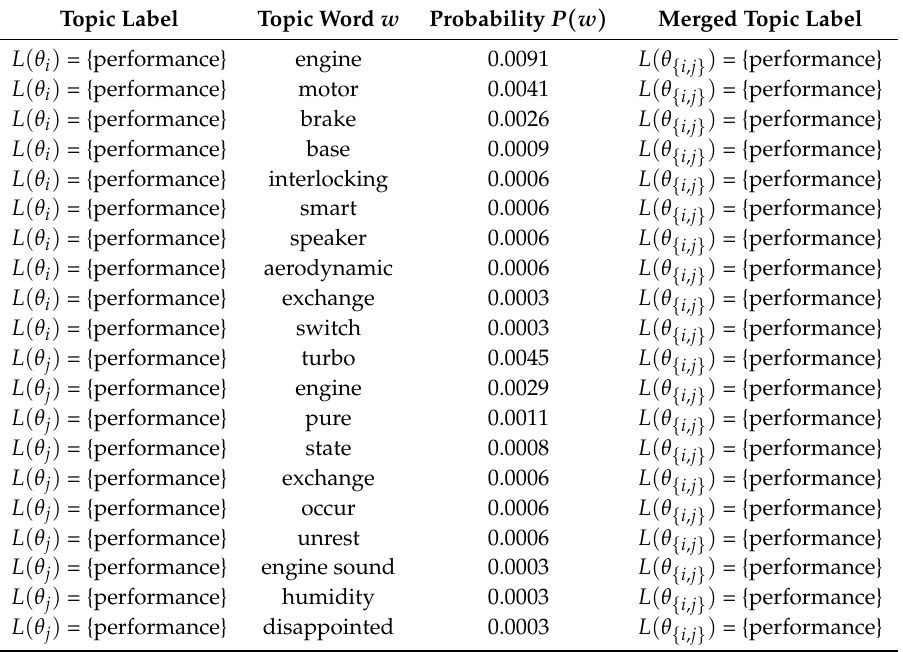
Table 2. An example of the topic merge problem— L ( θ { i } ) = {performance} and L ( θ { j } ) = {performance}. Topic Label Topic Word